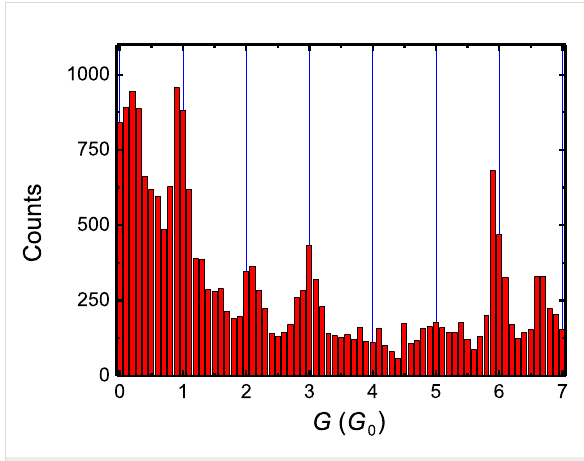
Figure 1: Conductance histogram of electrochemically deposited atomic-scale silver contacts giving evidence for different individual- atom and electronic-shell configurations. The histogram was obtained from >21000 conductance levels in the range between 0.01 G 0 and 7 G 0 , each level being stable for longer than 200 ms as measured at room temperature, presented with a bin size of 0.1 G 0 (1 G 0 = 2 e 2